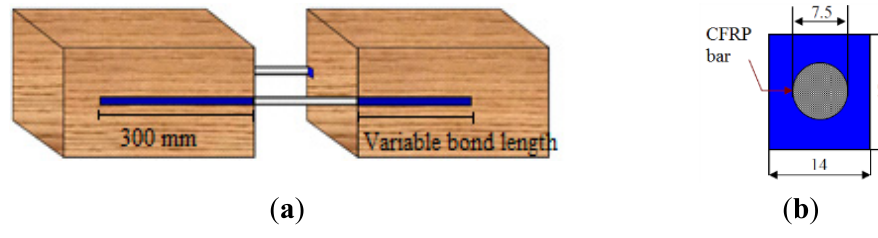
Figure 6. ( a ) CFRP bar schematic arrangement; ( b ) section of the notch (dimensions in mm).